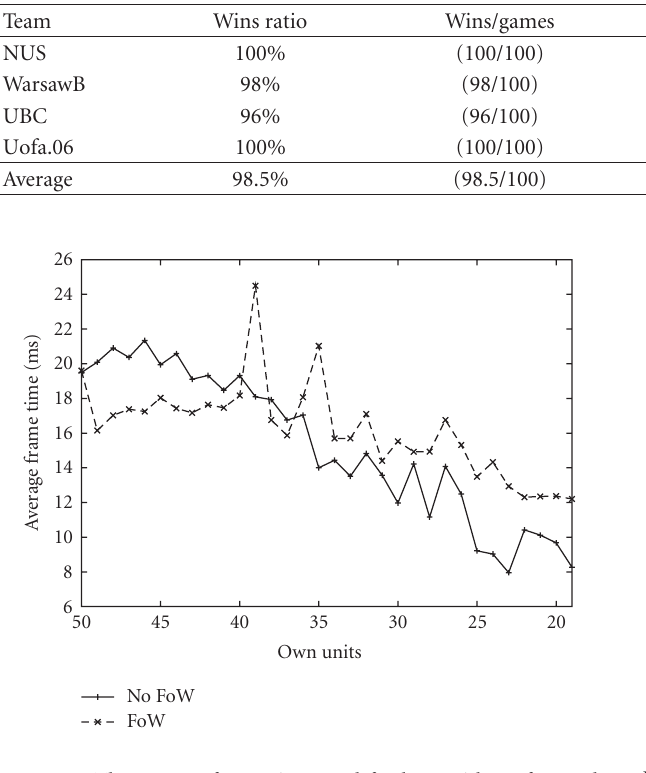
Figure 7: The average frame time used for bots with perfect and imperfect information about the game world.